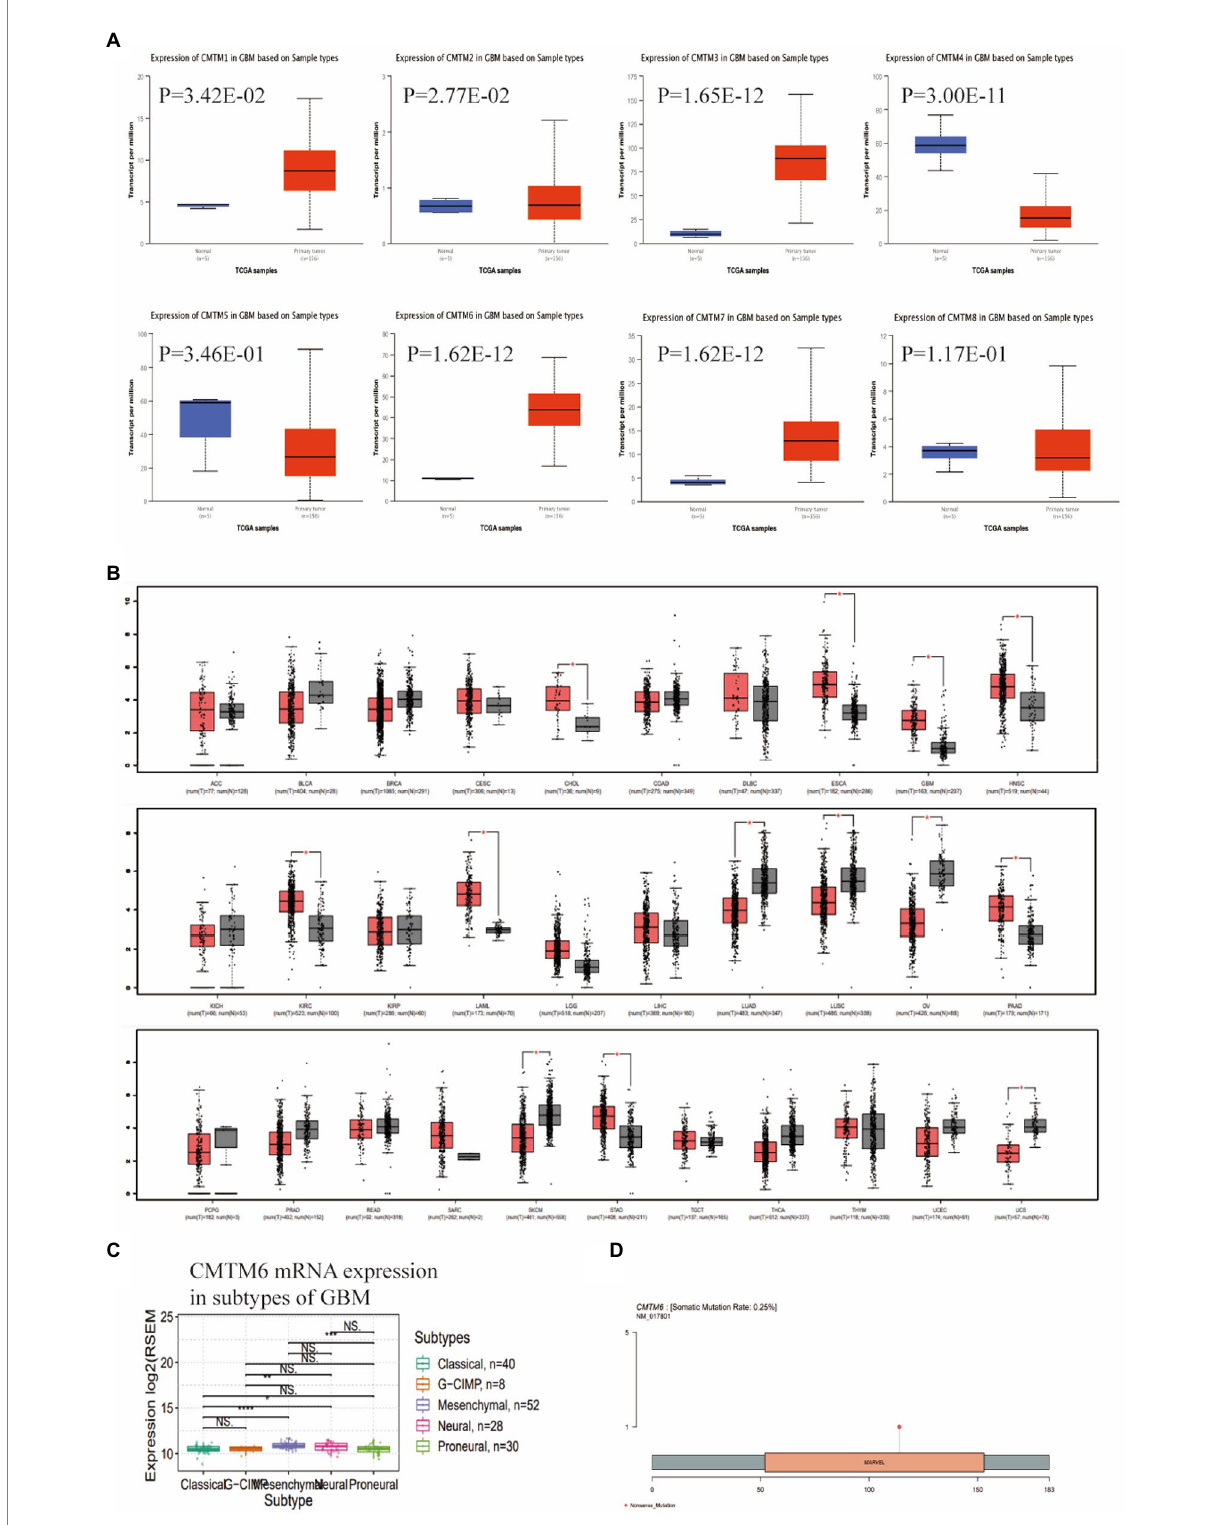
FIGURE 1 Expression of CMTM family in glioblastoma multiforme (GBM), Chemokine-like factor (CKLF)-like MARVEL transmembrane domain containing 6 (CMTM6) gene alteration and relationship with subtypes. (A) CMTM family expression levels in GBM were determined by UALCAN. (B) CMTM6 expression levels in pan-cancer from TCGA database were determined by GEPIA. (C) Gene alteration map of CMTM6 analyzed by GSCA website. (D) GSCA analysis of the relationship between CMTM6 and GBM